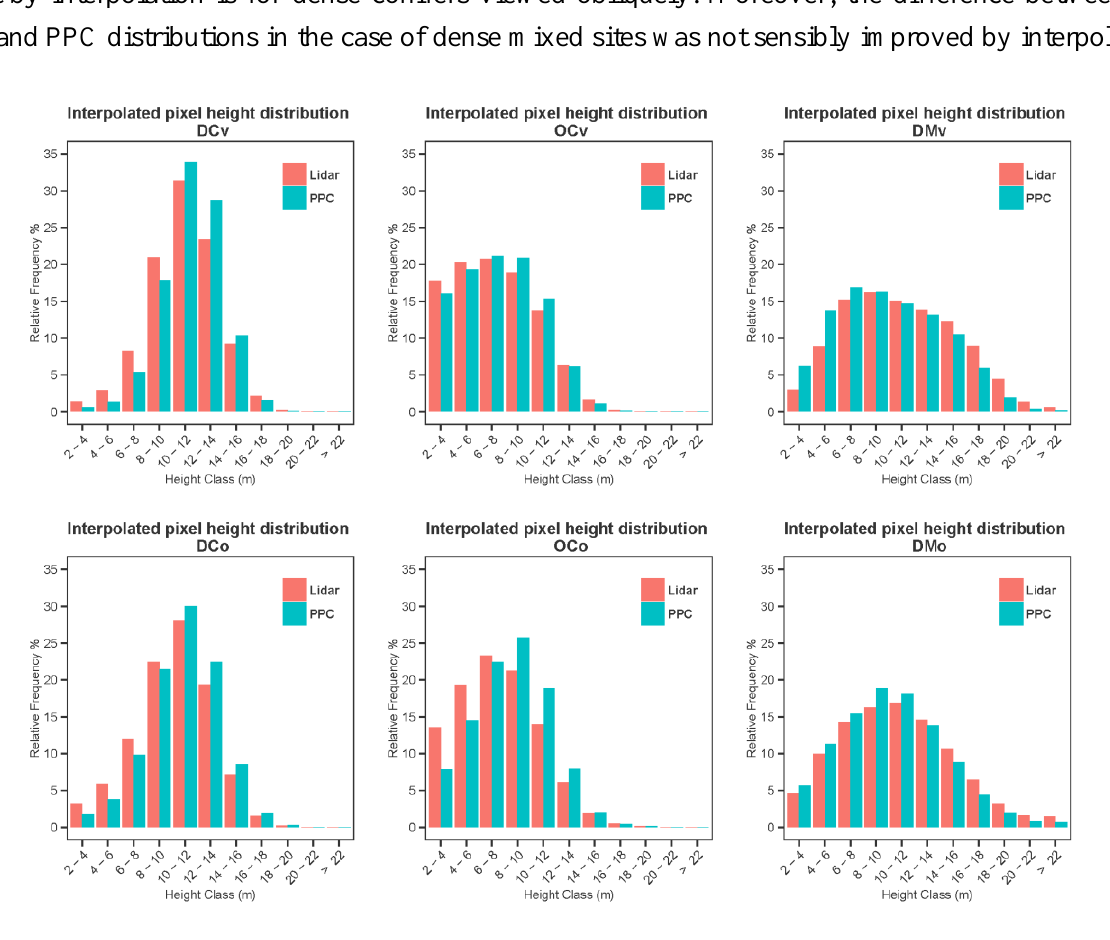
Figure 4. Relative point height distributions of lidar and photogrammetric points for corresponding locations of the interpolated